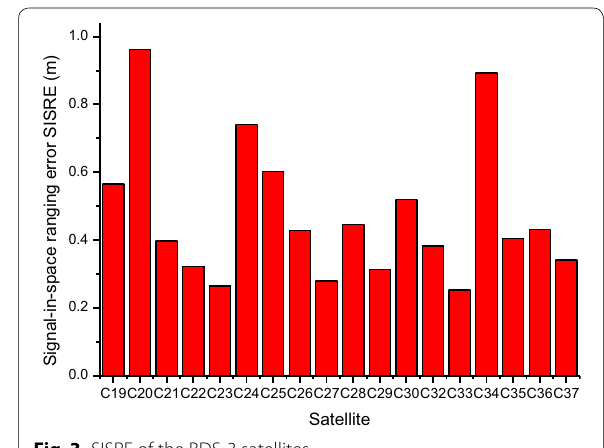
Fig. 3 SISRE of the BDS-3